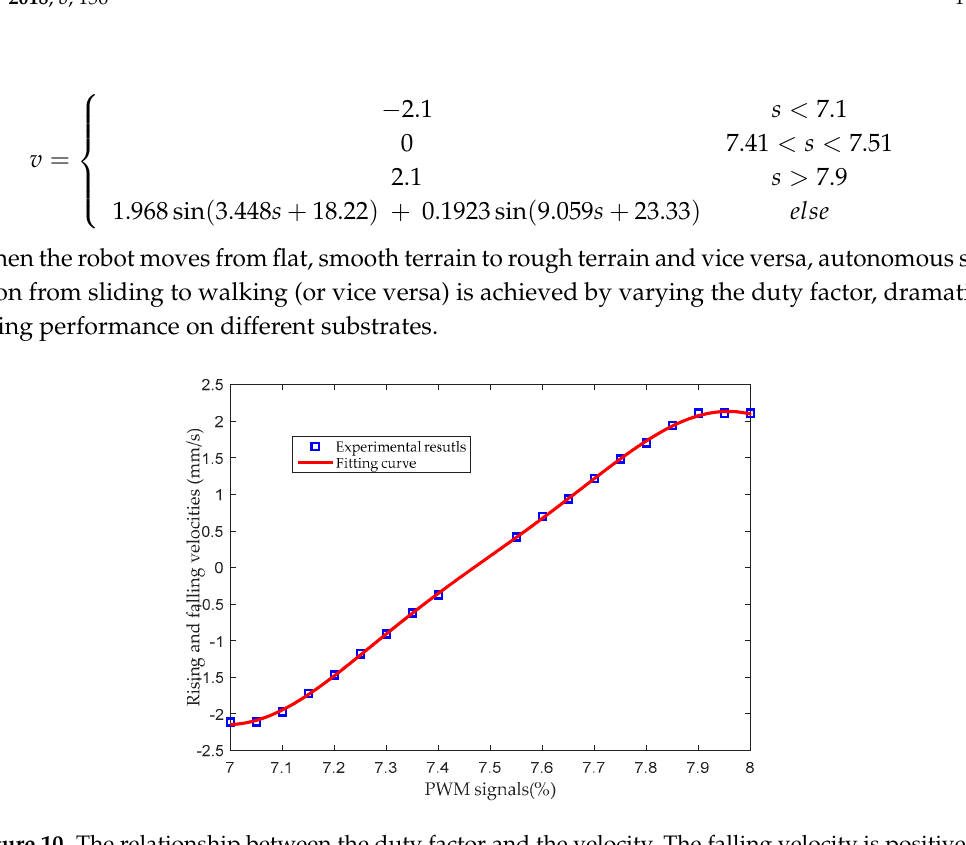
Figure 10. The relationship between the duty factor and the velocity. The falling velocity is positive, and the rising velocity negative .